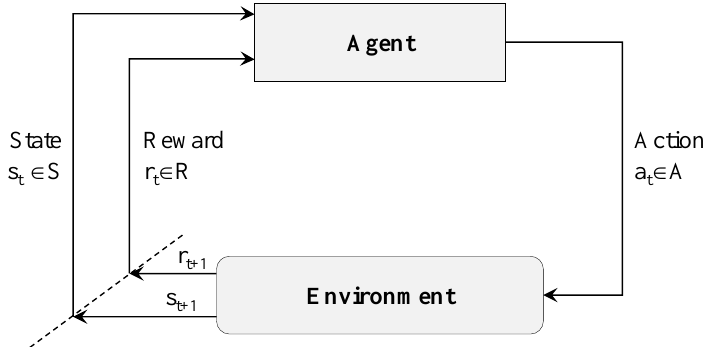
Figure 1. The interaction between agent and environment in RL. Deep reinforcement learning (DRL) is a subfield of machine learning, which uses deep learning (DL) concepts with RL to provide an optimal solution based on experience. This experience is based on the iterations and evaluating a reward function in determining the best behavior for an